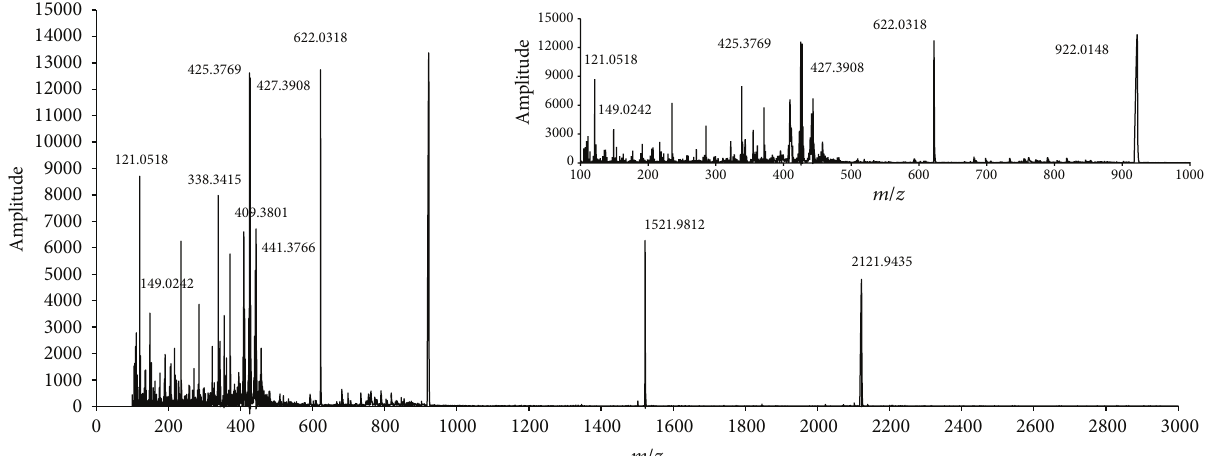
Figure 4: Mass spectrum of the DOM of size less than 0.45 𝜇 m obtained from HA. Spectrum registered with DSA-TOF-MS.